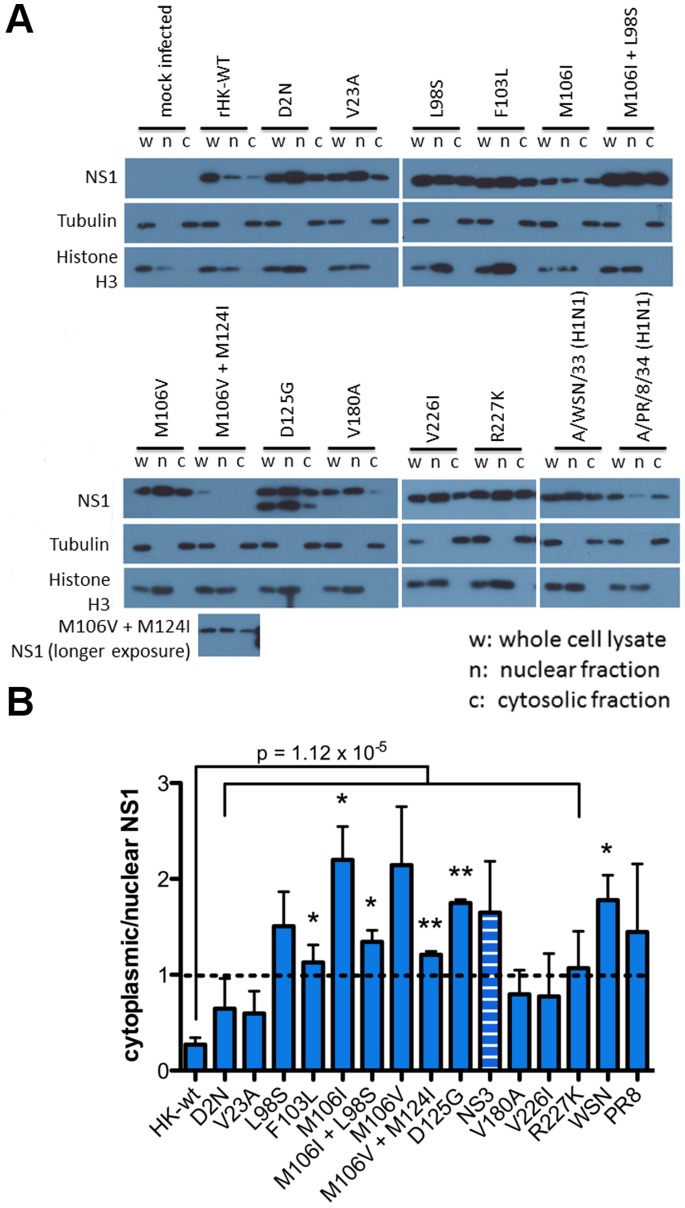
MA NS1 mutations alter subcellular localization of the NS1 protein in infected M1 cells.Mouse M1 cells were infected (MOI = 2) with rHK NS1 mutant viruses, the HK-wt virus, or the PR8, or WSN viruses, or mock infected with PBS. At 16 hpi the cells were lysed and differentially centrifuged to obtain whole cell (w), nuclear (n) and cytosolic (c) fractions. Cell fractions were resuspended in SDS buffer then were separated by SDS PAGE electrophoresis, followed by Western blot analysis to detect the NS1 protein as well as loading markers tubulin and histone H3. (A) Representative blot of 2–3 independent experiments, which were (B) analysed by densitometry where the amount of NS1 or NS3 protein in the nuclear and cytoplasmic fractions of a cell infected with a given virus was normalized to histone H3 and tubulin levels of the whole cell lysate, respectively. Cytoplasmic distribution was calculated by dividing cytoplasmic NS1 by nuclear NS1. Data represent the means ± SE (*p<0.05, **p<0.01; two-tailed student’s t-test).